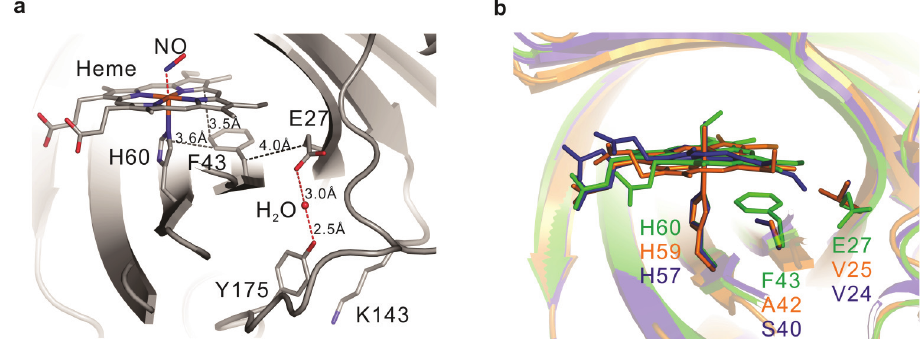
Figure 5. Local structural details of Glu27. Spatial location relative ( a ) to the heme cofactor and ( b ) with respect to His60 and Phe43. For comparison, the structures of NP7 (green), NP2 (blue) and NP4 (orange) are